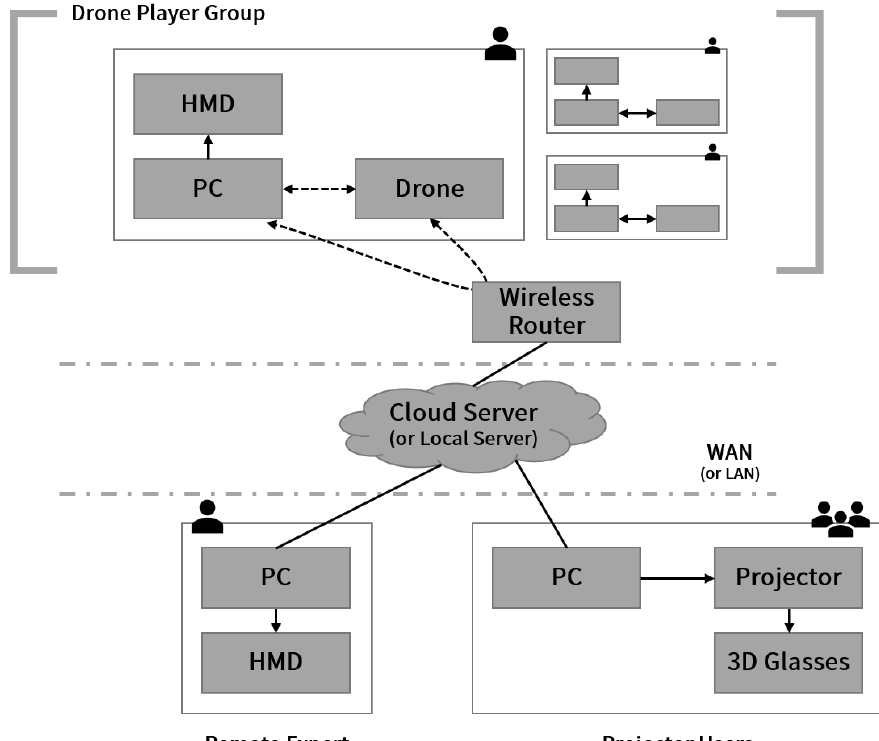
Figure 2. System configuration